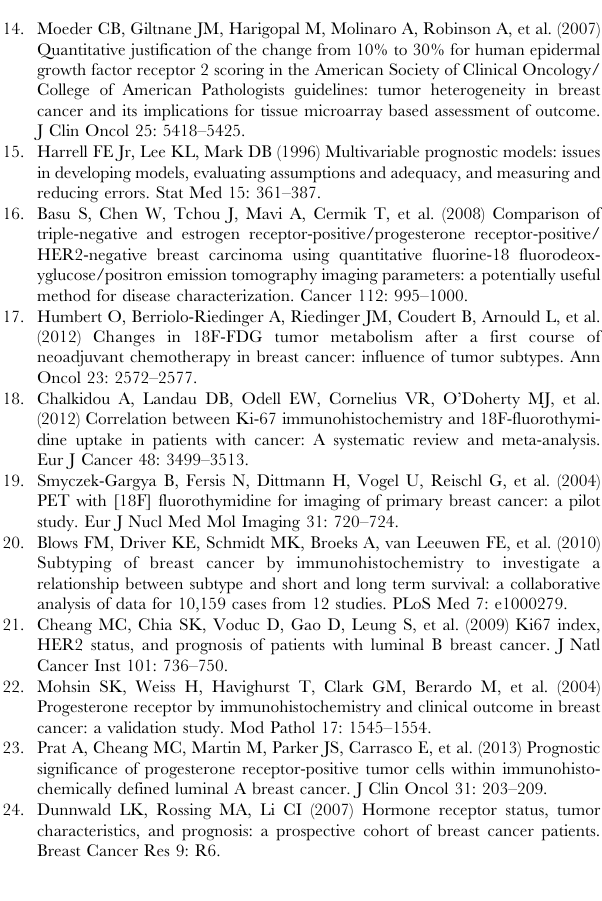
Figure S1 Consort chart showing the patients identified in our study. Figure S2 HER2-positive rates among the groups clas- sified with IHC markers and SUV max . Table S1 Univariate analyses according to tumor characteristics.